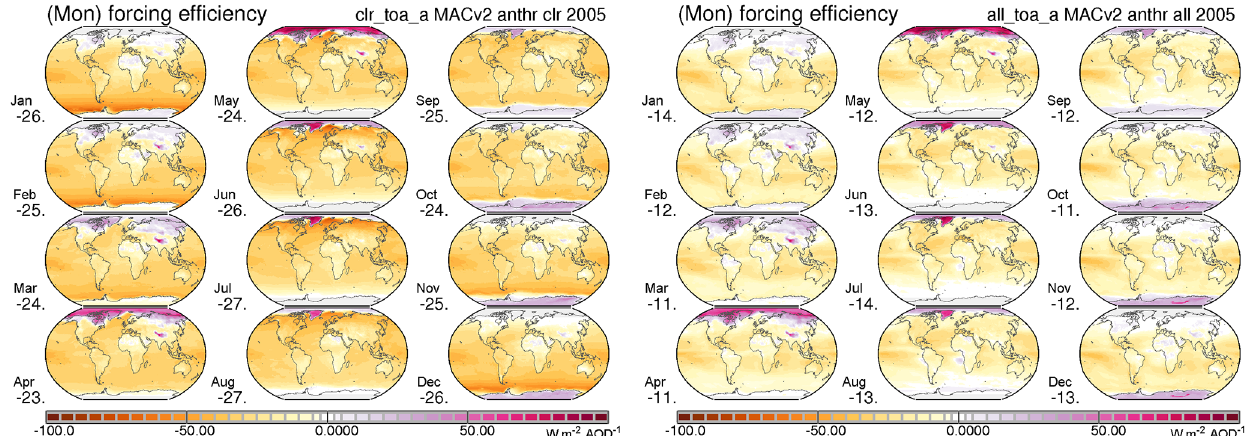
Figure D2. Monthly maps for the direct radiative forcing efficiency (per unit AOD) at the TOA by present-day anthropogenic aerosol for clear-sky (left frame) and all-sky conditions (right frame). Blue colors indicate climate cooling potential and red colors warming potential. Values indicate global